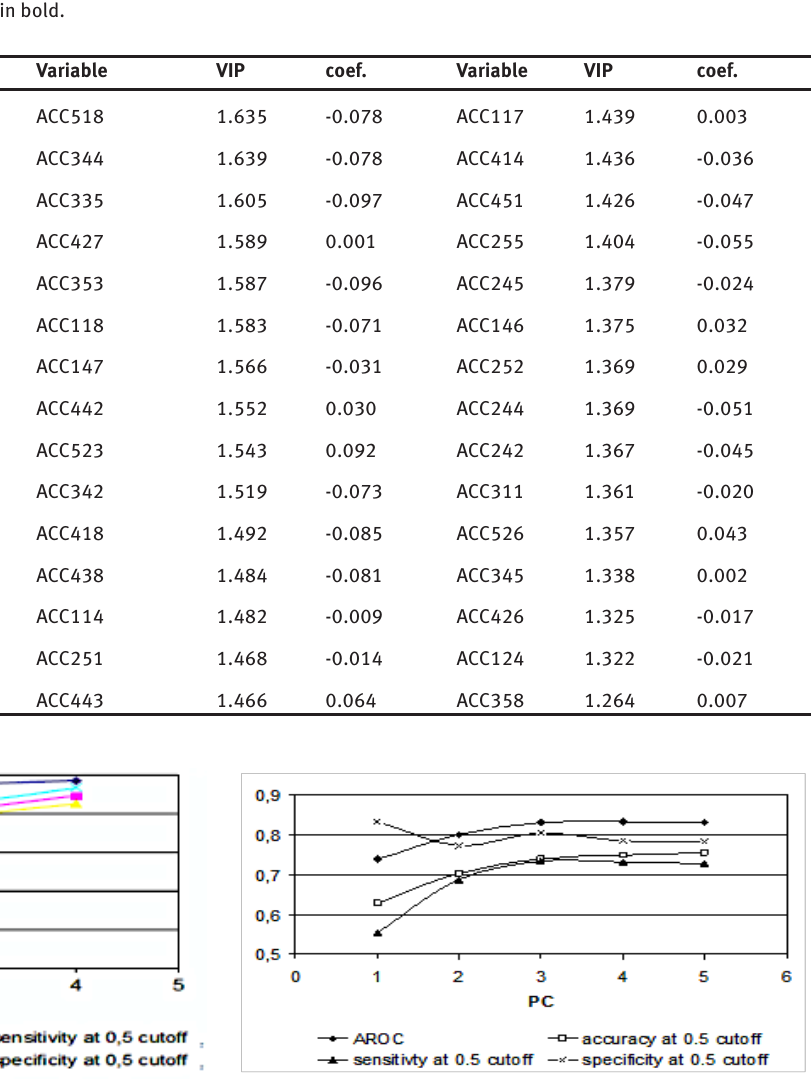
Figure 1: Sensitivity, specificity and accuracy at threshold 0.5, and AROC for the preliminary model for allergenicity prediction with different number of PCs.